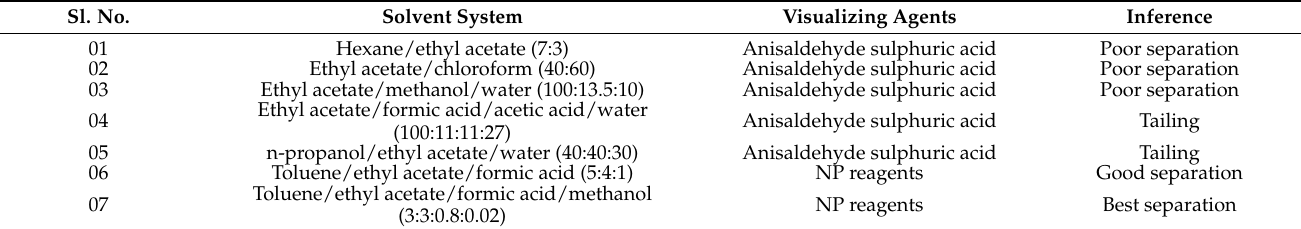
Table 1. TLC analysis of ethyl acetate fraction using different solvent systems and visualising agents.